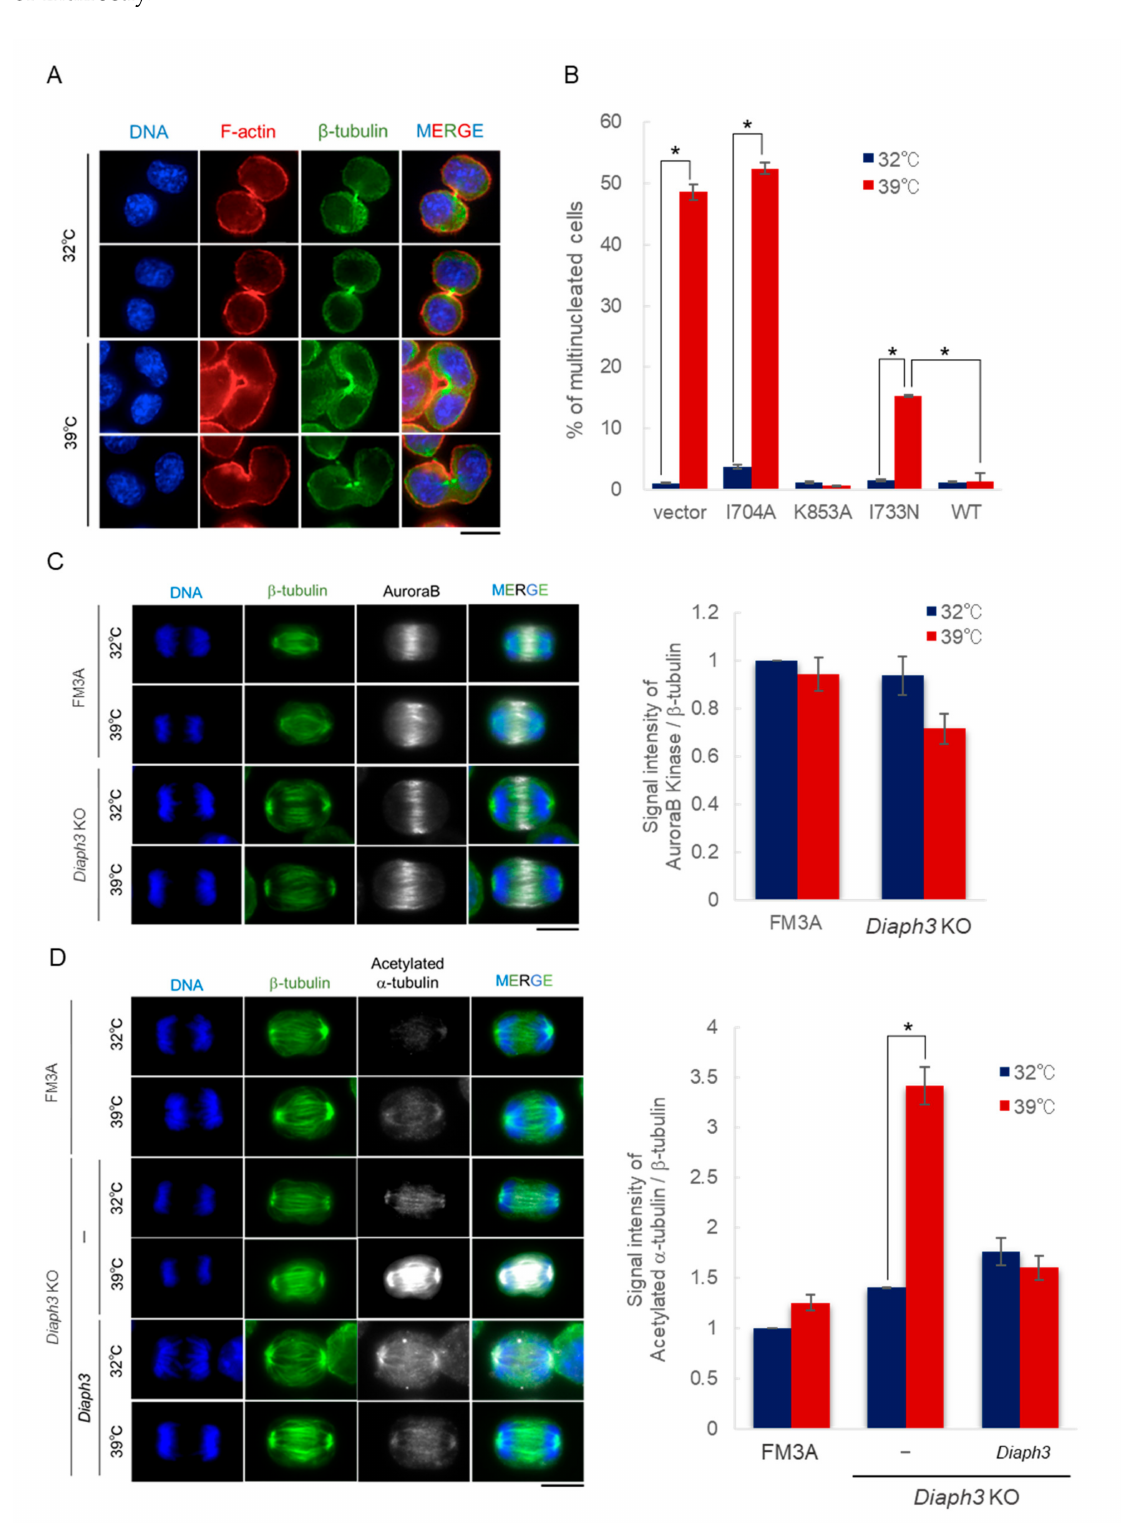
Figure 5. DIAPH3 contributes to the destabilization of microtubule in cytokinesis under